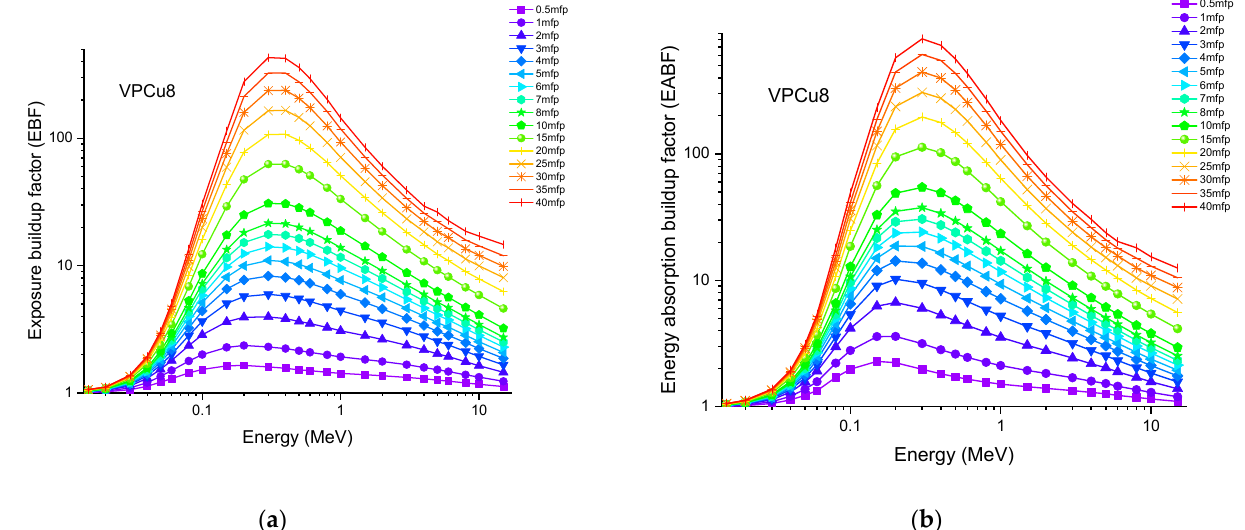
Figure 14. Variation of ( a ) EBF and ( b ) EABF against photon energy for sample VPB2Cu6.